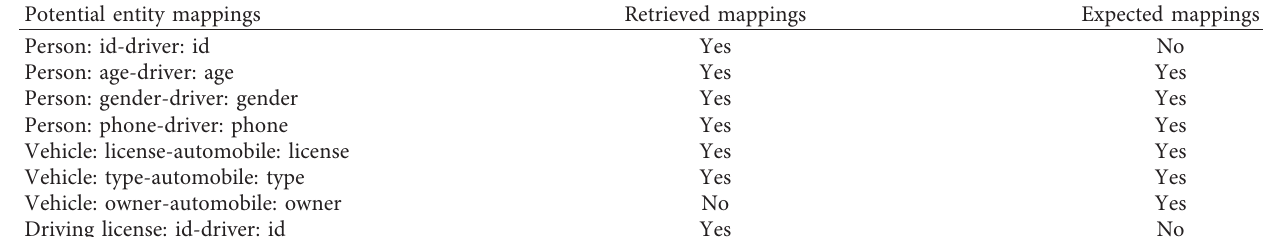
Table 12: Mapping built between attributes.